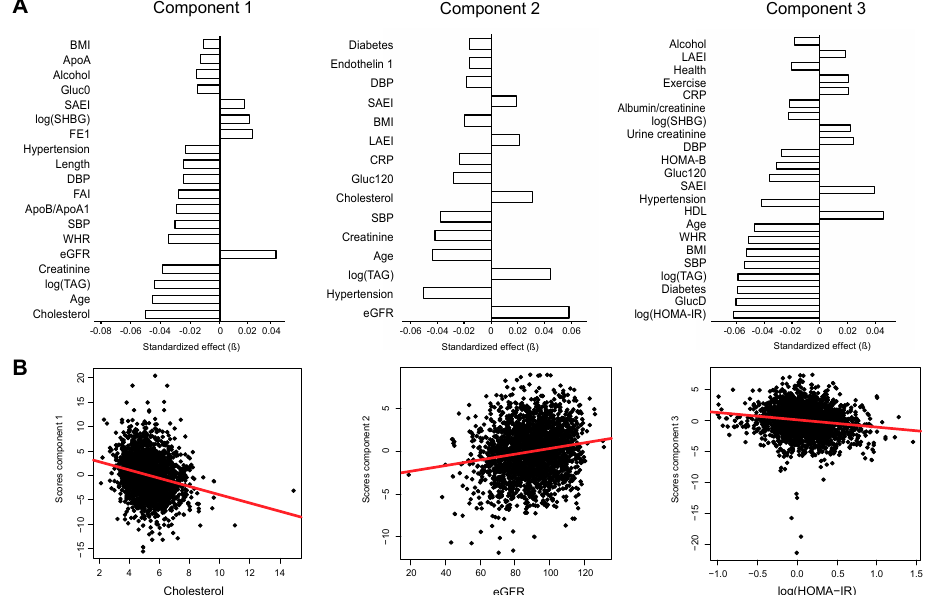
Figure 2. Principal components associate with distinct phenotypic features. ( A ) Associations of phenotypic traits with sample scores along the first three principal components (standardized regression coefficients, β ; q < 0.05). ( B ) Cholesterol associates strongly with component 1 (left panel), eGFR with component 2 (middle panel), and HOMA-IR with component 3 (right panel). The linear regression line is shown in red. Abbreviations: Alcohol, alcohol intake gram/week; ApoA, apolipoprotein A1; ApoB, apolipoprotein B; CRP, c-reactive protein; DBP, diastolic blood pressure; eGFR, estimated glomerular filtration rate; Gluc0, fasting glucose; Gluc120, 120 min oral glucose tolerance test (OGTT) glucose level; HOMA-B, homeostasis model assessment of beta-cell function; HOMA-IR, homeostasis model assessment of insulin resistance; LAEI, large artery elasticity index; SAEI, small artery elasticity index; SBP, systolic blood pressure; SHBG, sex hormone binding globulin; TAG, triacylglycerides; WHR, waist/hip-ratio.